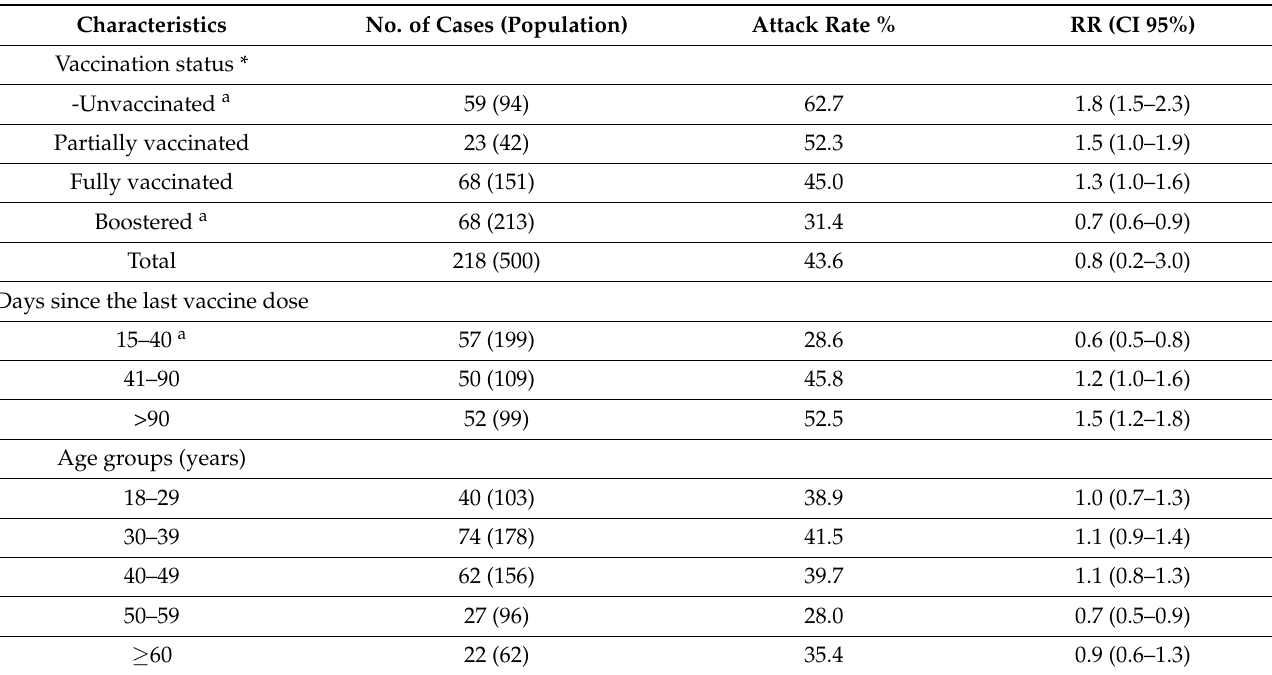
Table 2. SARS-CoV-2 attack rates and relative risk (RR) among inmates in the three prisons under study, by vaccination status, days since the last dose of vaccine, and age.